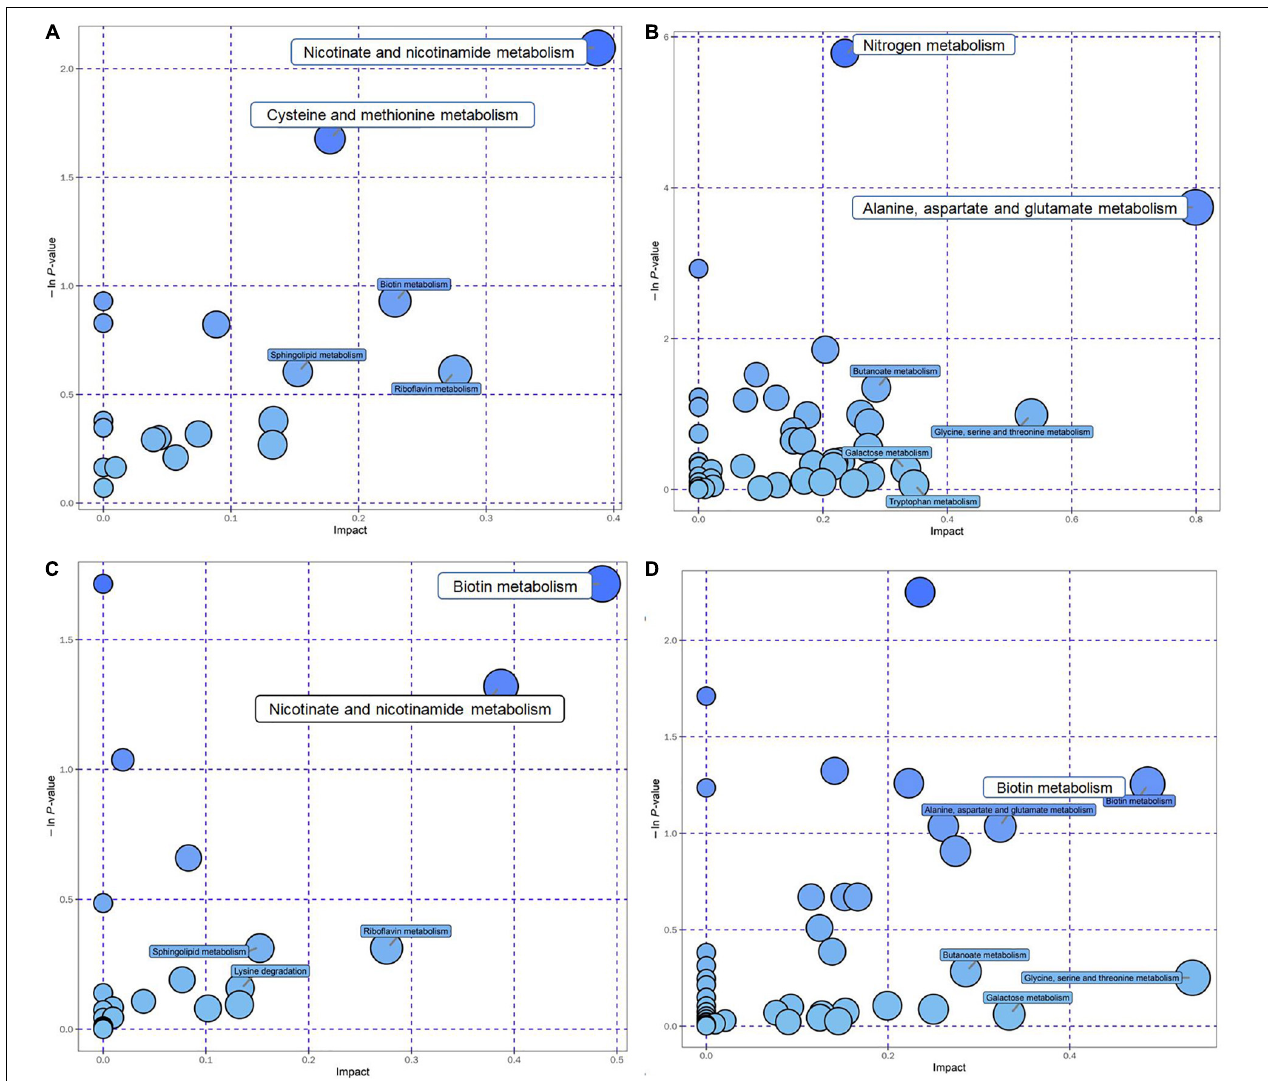
FIGURE 4 | The top KEGG pathways of groups with the addition of AE and HE vs. control are presented in the bubble chart. Each bubble in the bubble chart represents a metabolic pathway. The X -axis of the bubble and the bubble scale indicates the influence factor of the pathway in the topology analysis. The larger the size, the greater the influence factor; the Y -axis indicates the enrichment analysis. P -value [take the negative natural logarithm, namely, log10( p )]. (A) HE+(POS); (B) HE+(NEG); (C) AE+(POS); and (D)